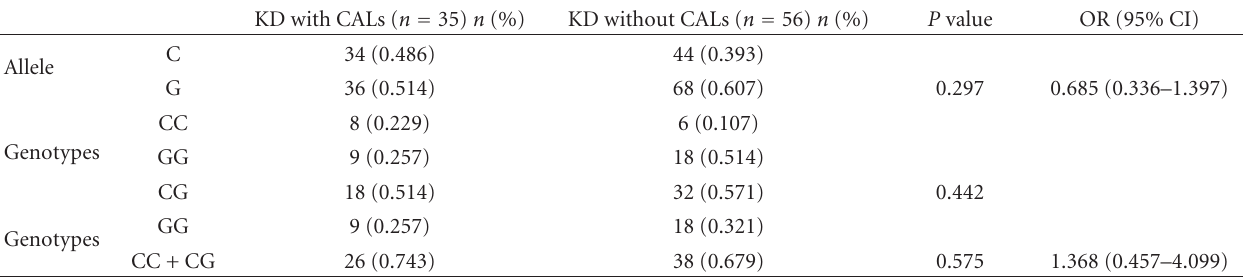
Table 5: RETN ( − 420C > G) genotype and allele frequency in the groups with CALs and without CALs.